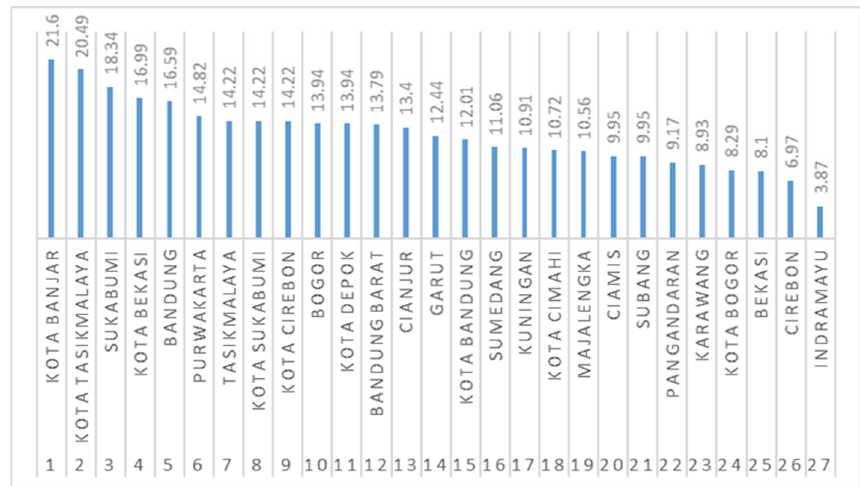
Figure 5. West Java Province EDRI Score (Source: BNPB).